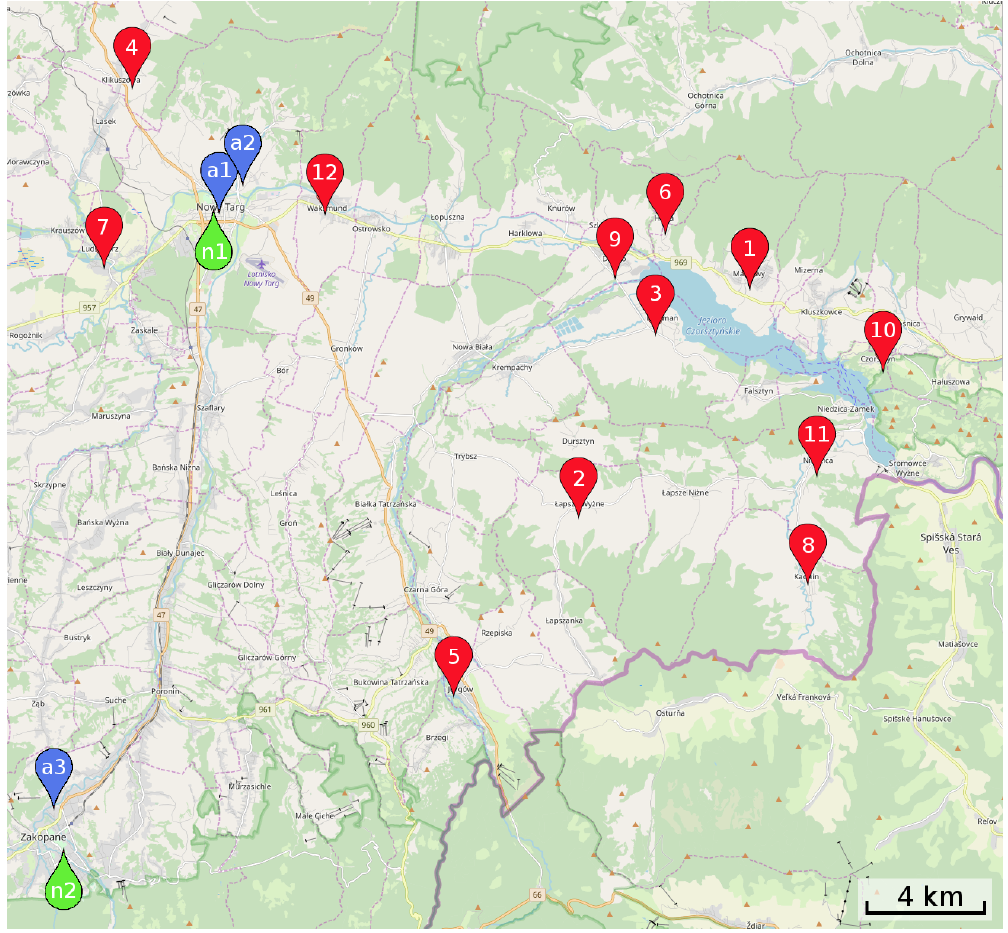
Figure 1. Air quality measurement locations. Markers: 1—School in Maniowy, 2—School in